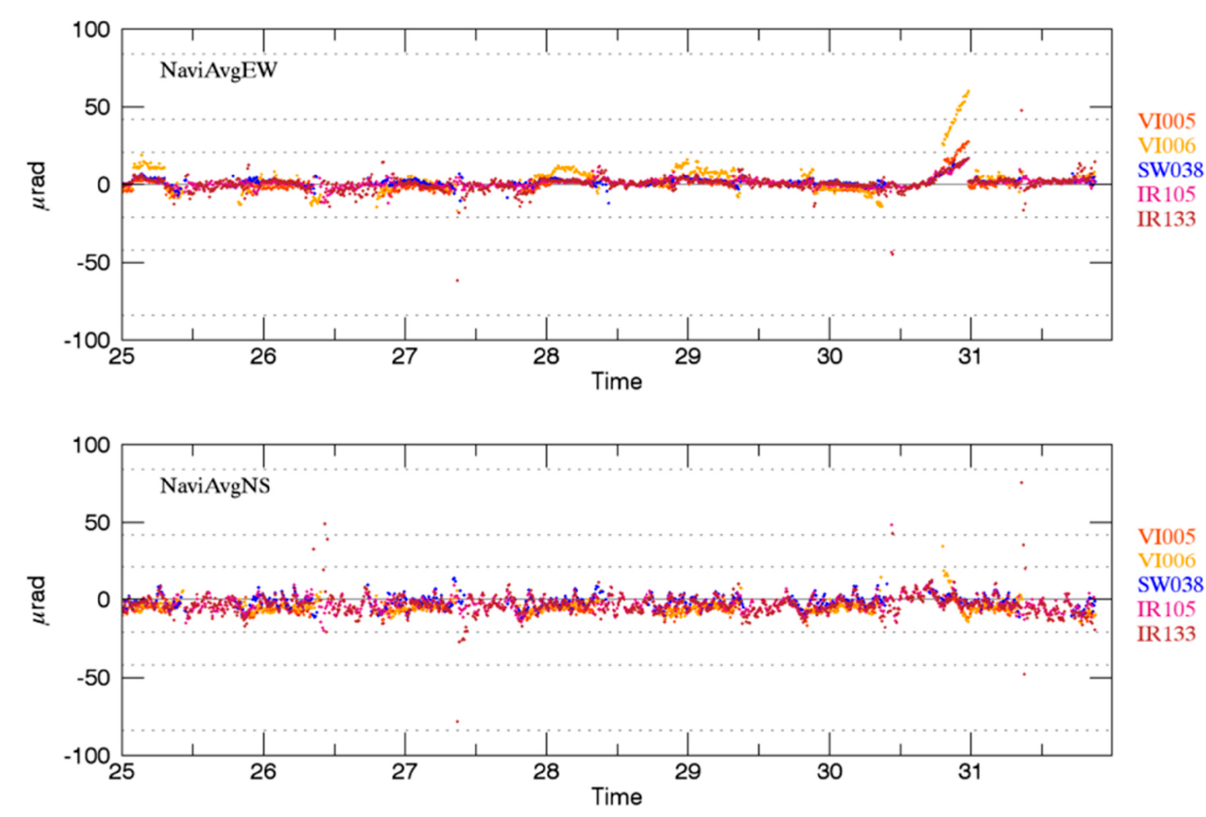
Figure 15. Time series plots of navigation performance for the five principal channels from 25 to 31 July 2019 since the start of normal operation. y -axis is the residuals in micro radian unit and the gray dotted lines represent criteria.